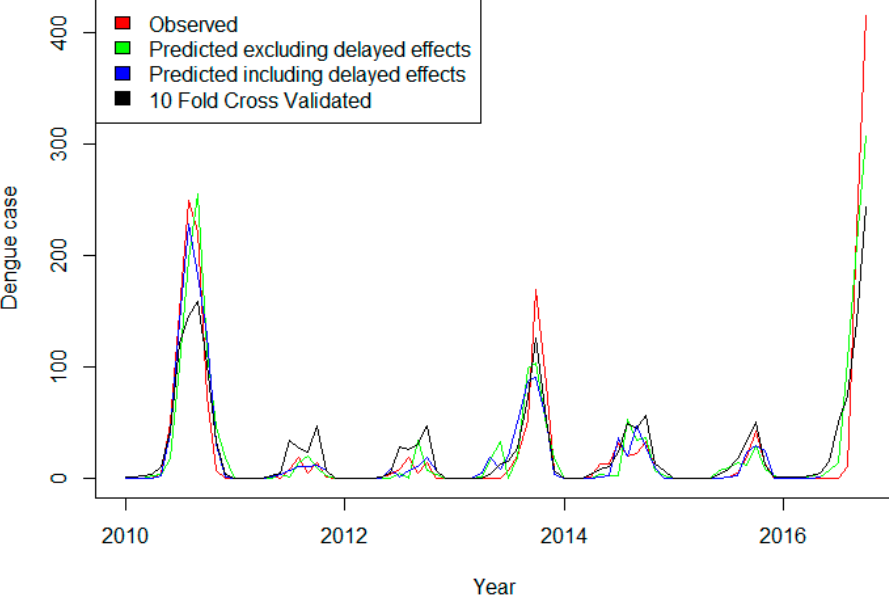
Figure 5. Observed, predicted excluding delayed effects, predicted including delayed effects, and 10-fold cross validated dengue cases based on Poisson generalized additive model. Models also included a natural cubic spline using 4 degrees of freedom for a months and years as a categorical variable.